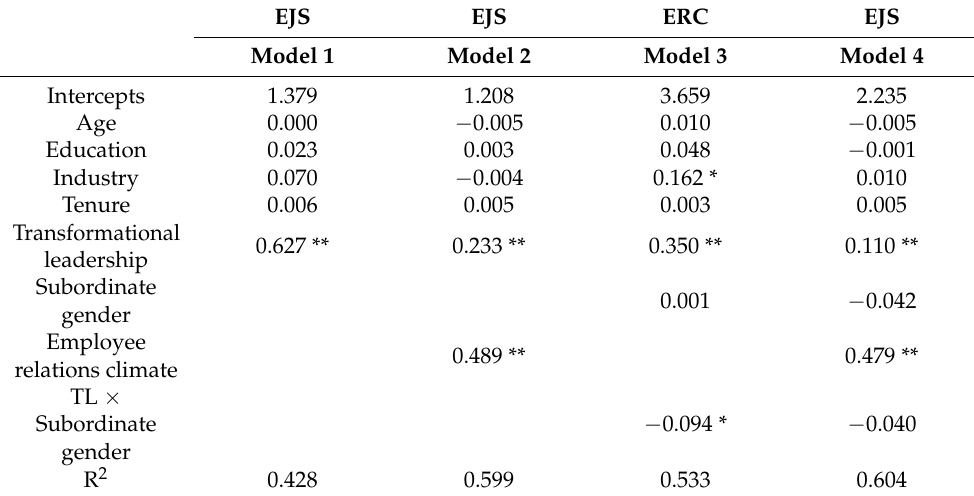
Table 3. Hierarchical multiple regression of employee relations climate and employee job